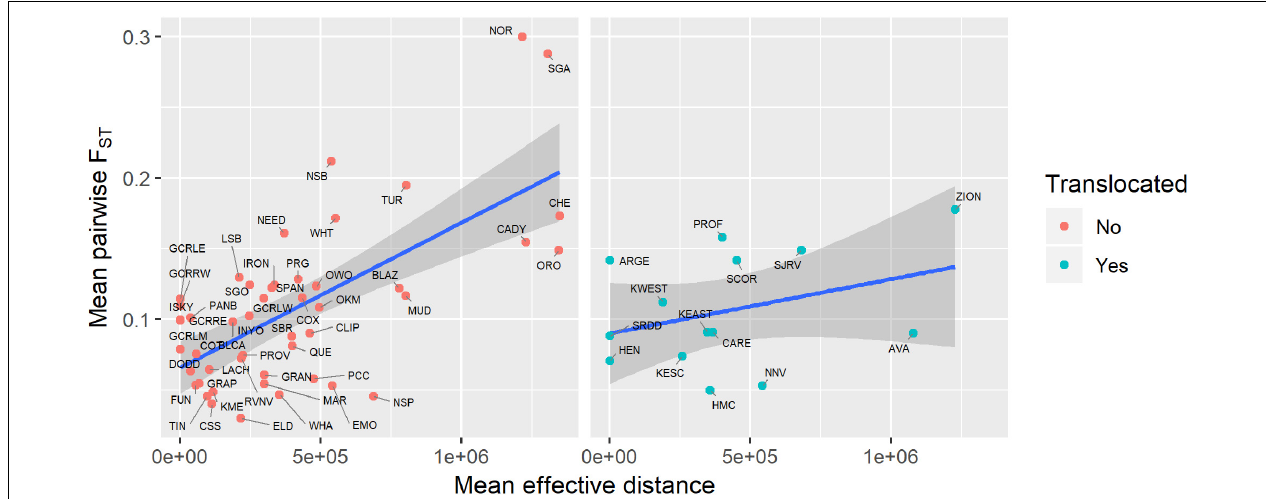
FIGURE 7 | Relationship between genetic isolation (measured as mean pairwise F ST with three nearest populations) and geographic isolation (measured as mean effective distance to nearest three neighbors) for native and translocated desert bighorn sheep populations. Blue line and dark gray band show best fit line and 95 percent confidence interval, respectively, from linear regression model. See Table 1 for full population